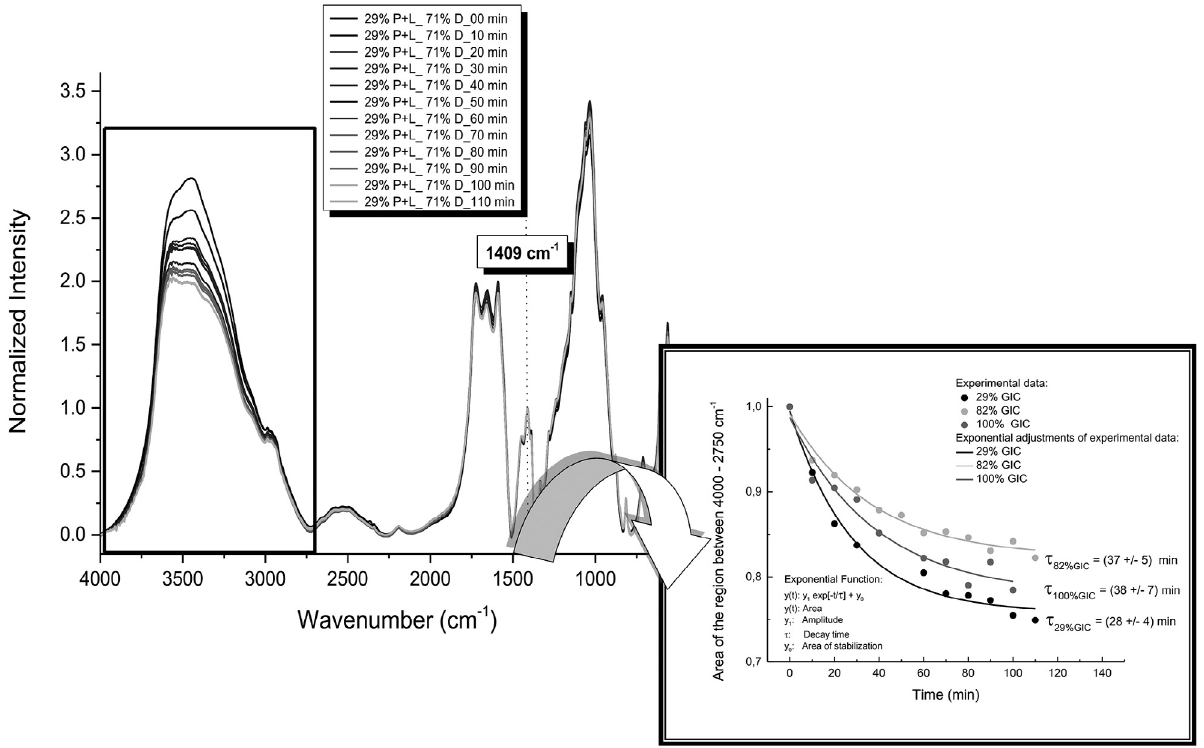
Figure 8- Fourier Transform Infrared Spectroscopy (FTIR) spectra of the sample 29% P+L_71% D as a function of time. The sample was measured up to 110 min, at intervals of 10 minutes. The spectra normalization of the spectra was at 1409 cm -1 . The inset shows the area of the region between 4000-2750 cm -1 as a function of time for three concentrations of 100%, 82% and 29% of glass-ionomer cement (GIC). An exponential fitting with Eq (1) was performed to obtain the characteristic decay time (τ) of GIC interaction with